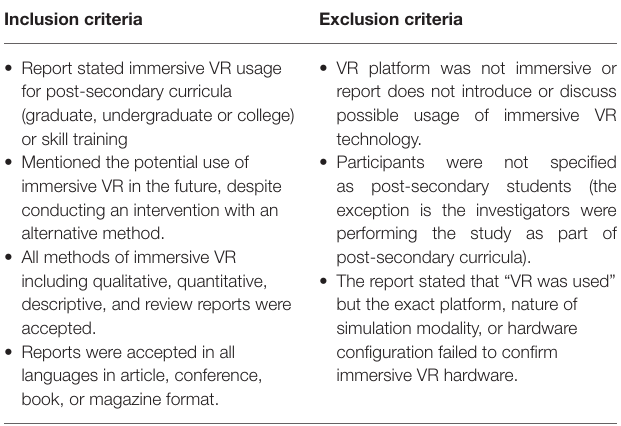
TABLE 2 | Search criteria and terms. TABLE 3 | Determining the purpose of immersive Virtual Reality in Post-secondary